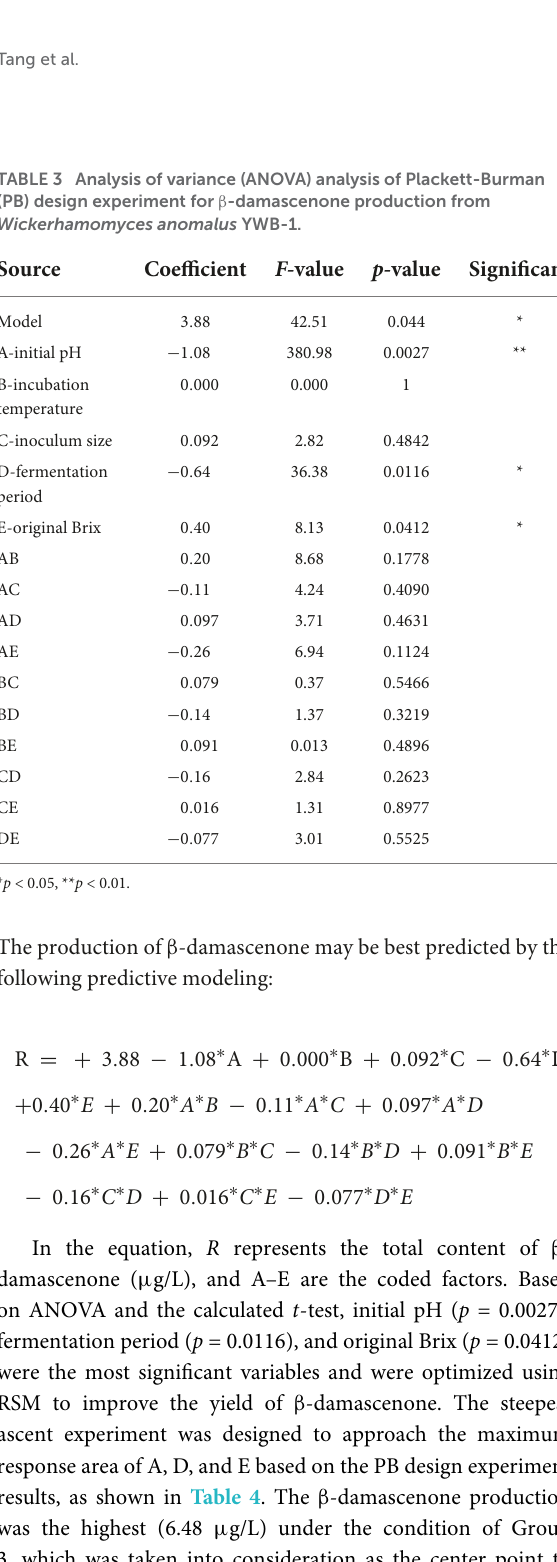
TABLE 3 Analysis of variance (ANOVA) analysis of Plackett-Burman (PB) design experiment for β -damascenone production from Wickerhamomyces anomalus YWB-1.